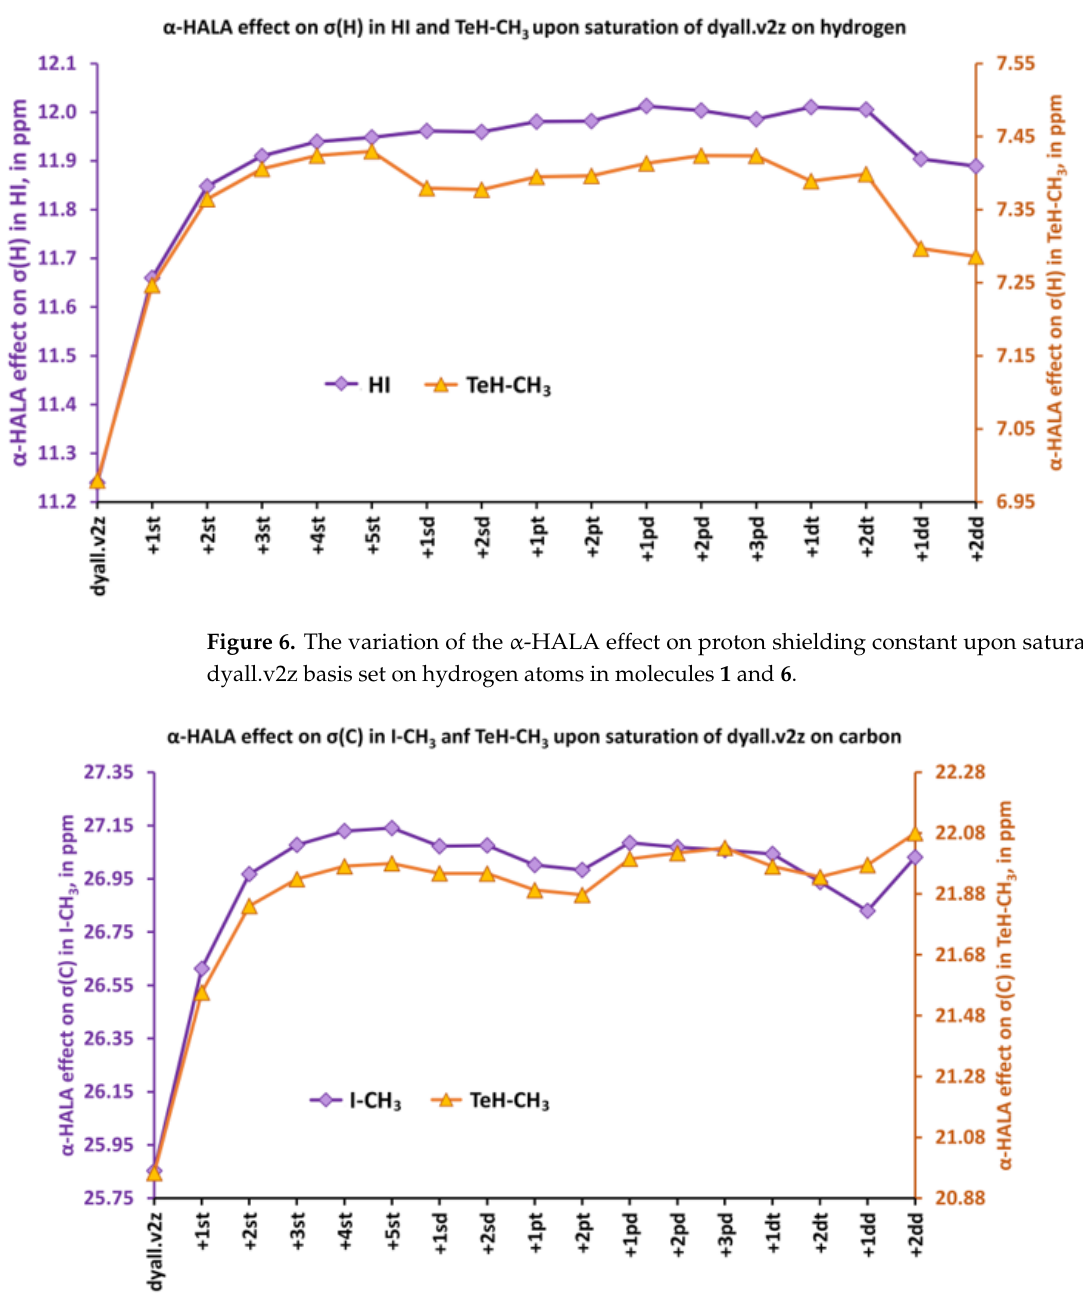
Figure 7. The variation of the α -HALA effect on the carbon shielding constant upon saturation of the dyall.v2z basis set on the carbon atom in molecules 2 and 6 .